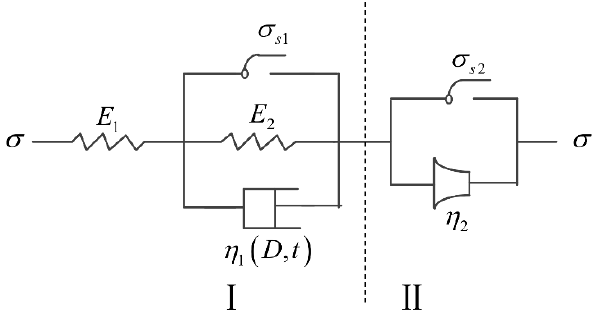
Figure 1. The unified core damage model.